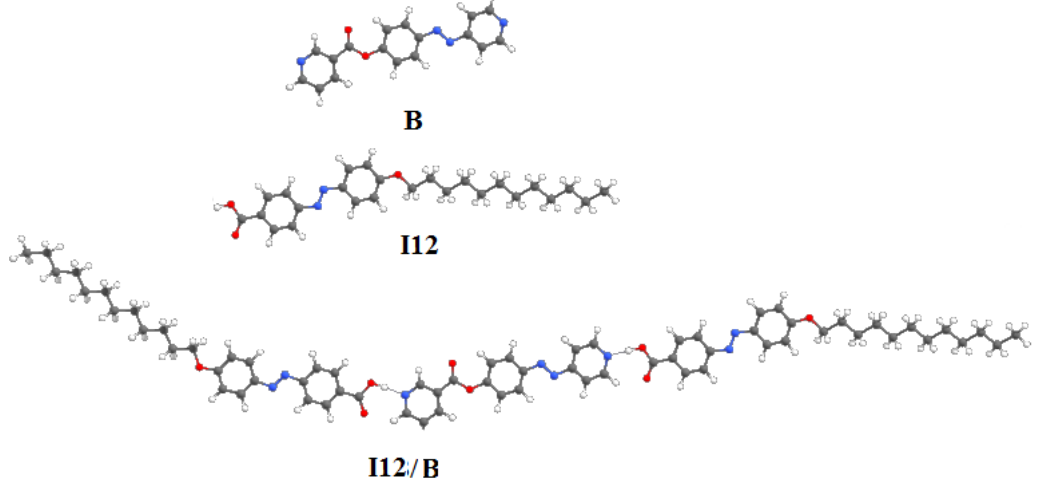
Figure 7. The calculated geometry of B , I12 and I12/B.